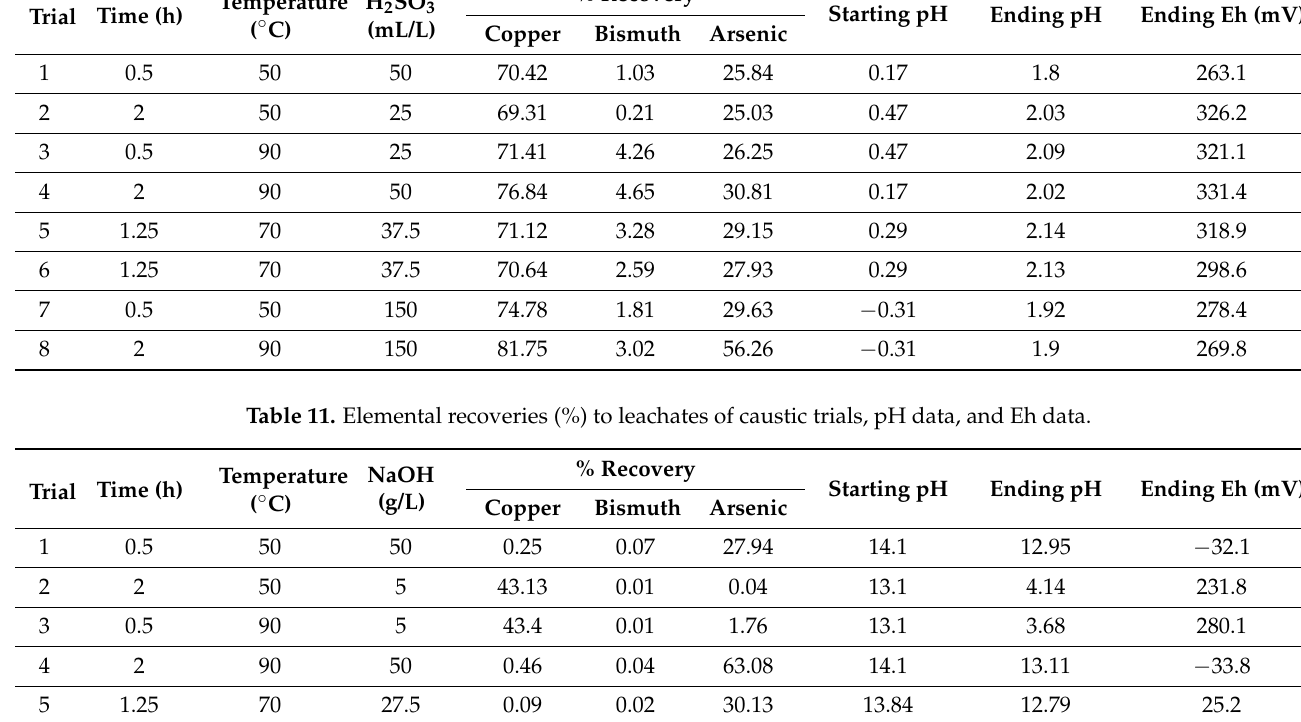
Table 10. Elemental recoveries (%) to leachates of sulfurous acid trials, pH data, and Eh data. Trial Time (h)